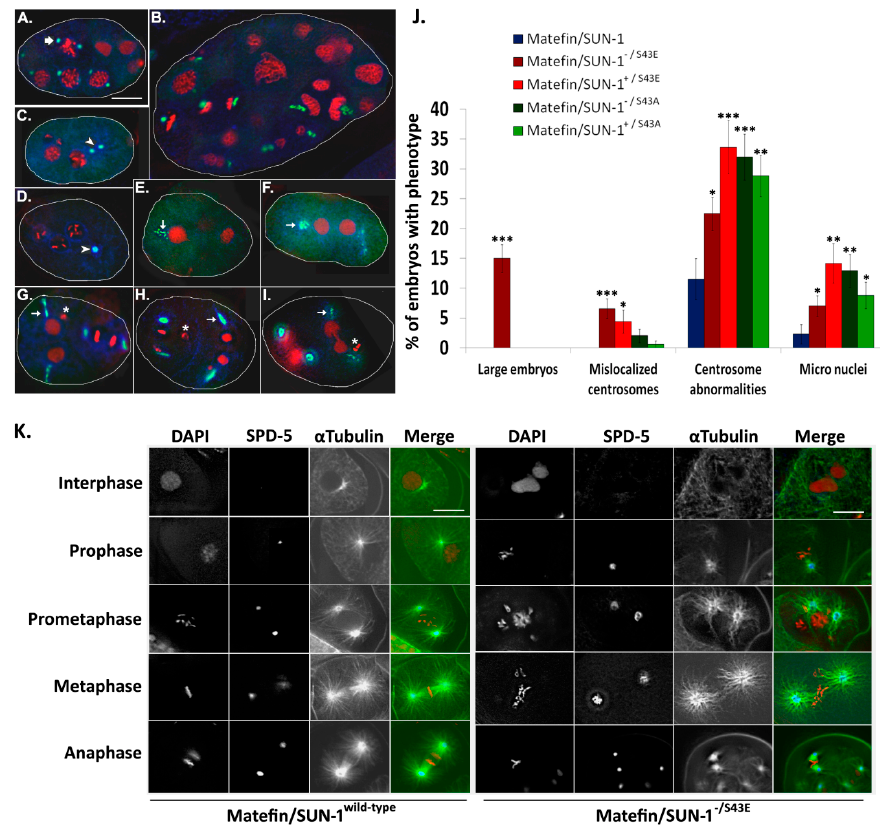
Figure 4. Matefin/SUN ‐ 1 S43 is involved in maintaining centrosome shape and function. DNA and centrosome phenotypes were analyzed in early C. elegans embryos expressing matefin/SUN ‐ 1 S43 phosphorylation mutations. ( A – I ) embryos stained with DAPI ( red ), anti ‐ GFP ( blue ) and anti SPD ‐ 5 ( green ) antibodies; Phenotypes observed: Large embryos with large nuclei ( B ); mislocalized centrosomes (arrowheads C – D ) centrosome abnormalities (centrosome break ‐ down (arrows E , F ) and centrosome stretch (arrows G – H )) and micro nuclei (stars G – I ); Scale bar 10 μ m. ( J ) percentage of embryos displaying phenotypes in the different matefin/SUN ‐ 1 strains: Large embryos (matefin/SUN ‐ 1 − /S43E p value = 1.5 × 10 − 9 ); mislocalized centrosomes (matefin/SUN ‐ 1 − /S43E p value = 8.6 × 10 − 5 ; matefin/SUN ‐ 1 +/S43E p value = 0.02); centrosome abnormalities (matefin/SUN ‐ 1 − /S43E p value = 0.01; matefin/SUN ‐ 1 +/S43E p value = 0.0001; matefin/SUN ‐ 1 − /S43A p value = 9.9 × 10 − 5 ; matefin/SUN ‐ 1 +/S43A p value = 0.0005) and micro nuclei (matefin/SUN ‐ 1 − /S43E p value = 0.04; matefin/SUN ‐ 1 +/S43E p value = 0.001; matefin/SUN ‐ 1 − /S43A p value = 0.001; matefin/SUN ‐ 1 +/S43A p value = 0.02); ( K ) matefin/SUN ‐ 1 S43E expression leads to disorganization of α‐ tubulin filaments in early embryos. Wild type matefin/SUN ‐ 1 embryos ( left ) and matefin/SUN ‐ 1 S43E embryos ( right ) stained with DAPI ( red ), anti SPD ‐ 5 ( blue ) and anti α‐ tubulin antibodies ( green ) during different stages of cell cycle. Scale bar 10 μ m. Error bars represent SEM. * p < 0.05, ** p < 0.005, *** p < 0.0005 as compared to wild ‐ type.